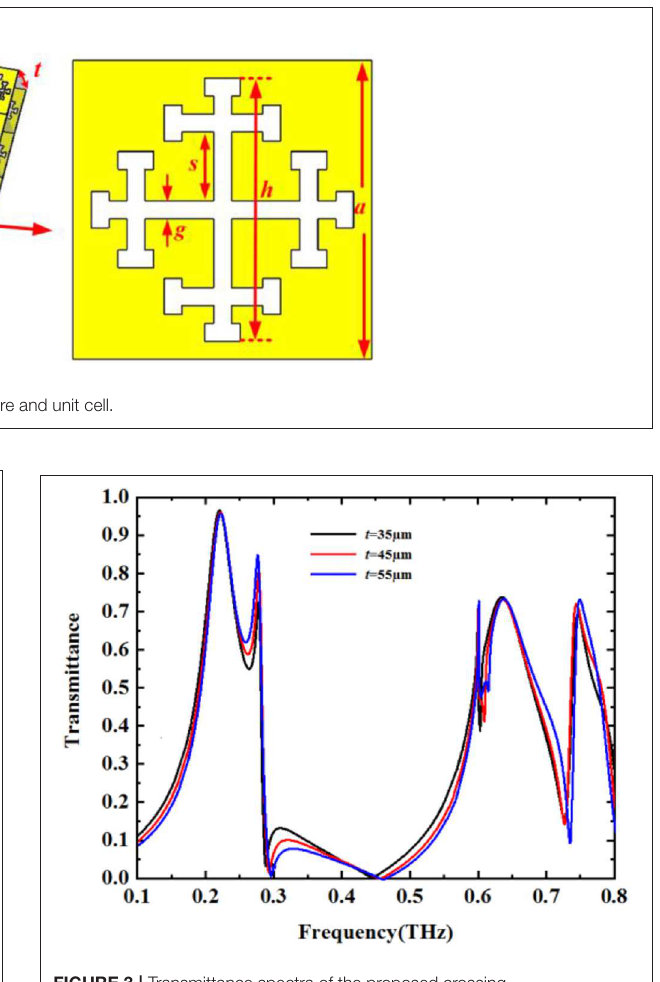
Frontiers in Physics |